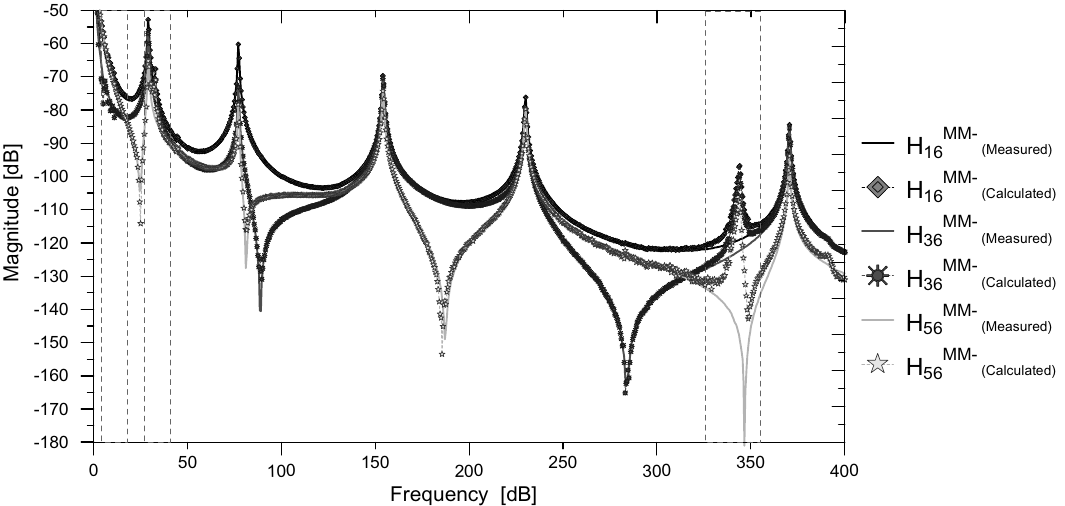
Fig. 11. Measured and estimated Resceptances H (cid:2) 16 ,H (cid:2) 36 and H (cid:2) 56 for mass modified structure (MM-).